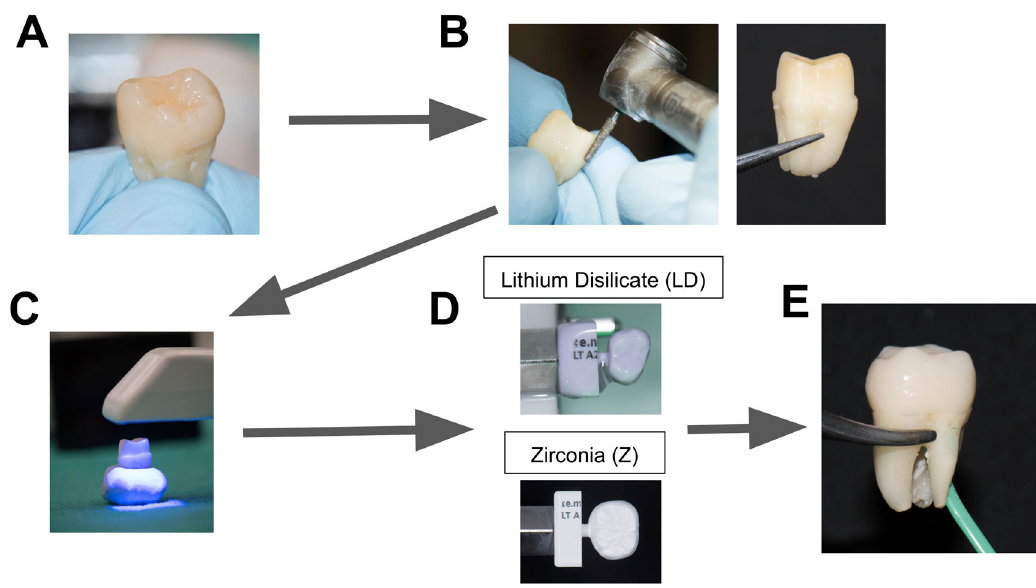
Figure 1. Specimen preparation. ( A ) Recently discarded extracted natural teeth were selected and cleaned, ( B ) the tooth was prepared for the crown, ( C ) the tooth was scanned using an intraoral scanner and the digital design was done, ( D ) the crown was milled, ( E ) the crown was cemented and the temperature probe was